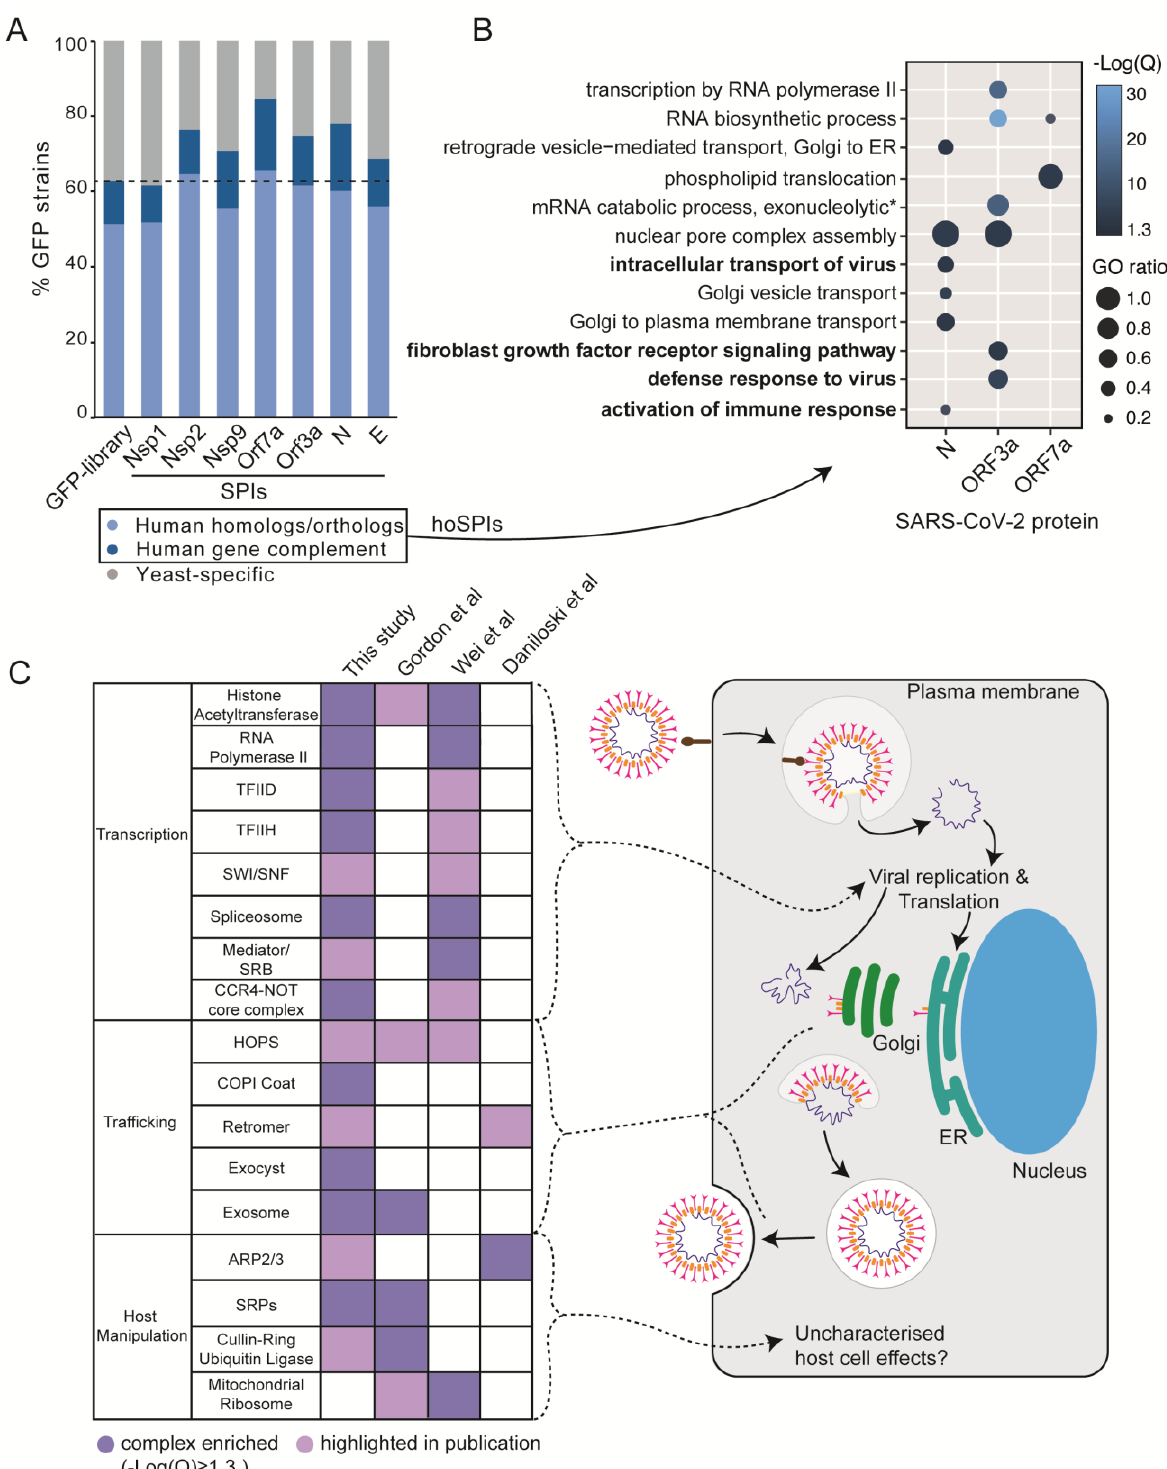
FIGURE 4: SARS-CoV-2 SPI screens in the context of human genetics. (A) The SARS-CoV-2 yeast SPIs are collectively enriched for those that have human homo- logues or orthologues compared to the GFP strains tested (Fishers exact test, p=7.8x10 -8 ). Human Gene Complement indicates those human genes that have been demonstrated to complement the loss of the yeast homolog/ortholog. (B) Enrichment analysis of GO biological process terms of human orthologues of the SARS- CoV-2 SPIs (hoSPIs). Bold terms indicate human specific GO terms, that are not present in yeast. The -Log(Q) value is illustrated by blue shading, all -Log(Q) values are greater than or equal to 1.3, which is equivalent to q-values < 0.05. GO ratio (size of the circle) indicates the proportion of genes in a GO term were found for each enrichment. (C) A comparison of the complexes that contain hoSPIs with those identified from three SARS-CoV-2 screens performed in mammalian cells. Dark purple shading indicates enrichment, light purple shading highlights complexes which are mentioned by the authors. These complexes correspond to the various steps in the viral lifecycle